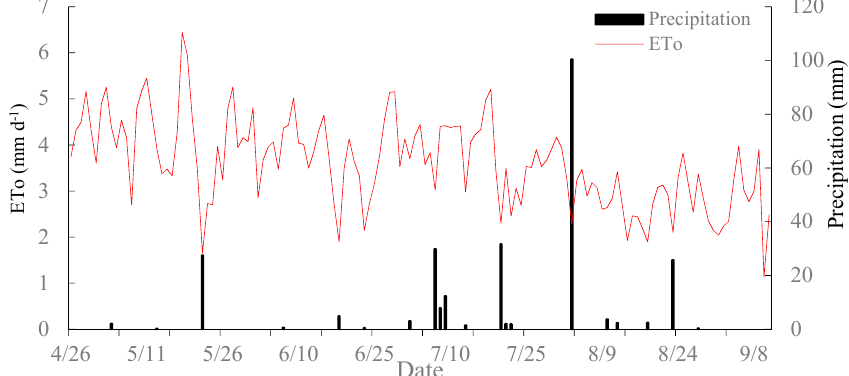
Figure 4. Variation of the reference crop evapotranspiration and precipitation during the growth period of maize. Note: ET o represents reference crop evapotranspiration, mm. ET o was calculated by means of the FAO Penman–Monteith Equation (2) for the entire growth season of maize.